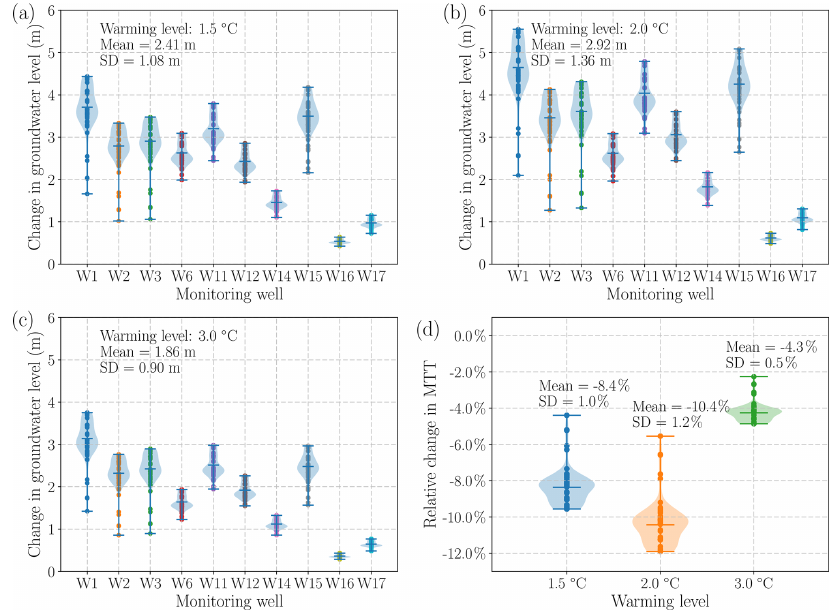
Figure 9. The predictive uncertainty in simulation results related to different hydraulic-conductivity fields. Panels (a) , (b) , and (c) show the changes in groundwater levels, whereas panel (d) shows the projected relative changes in MTTs using 80 different hydraulic-conductivity